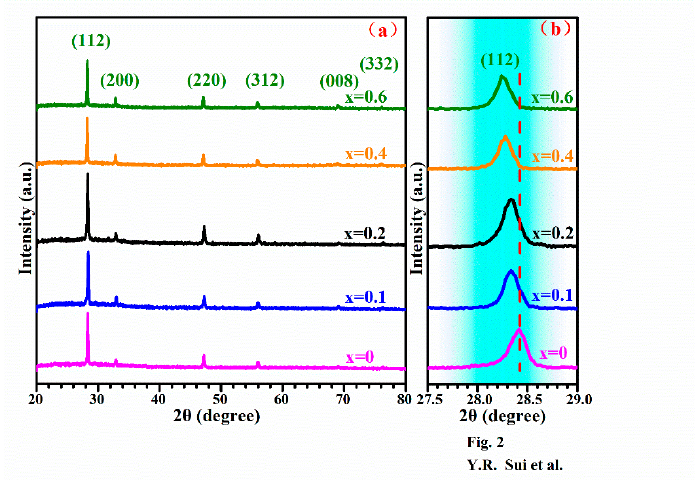
Figure 2. ( a ) XRD spectra of Cu 2 Mg x Zn 1 − x SnS 4 (0 ≤ x ≤ 0.6) thin films. ( b ) Enlarged view of the corresponding (112) di ff raction peaks of the Cu 2 Mg x Zn 1 − x SnS 4 (0 ≤ x ≤ 0.6) thin films.